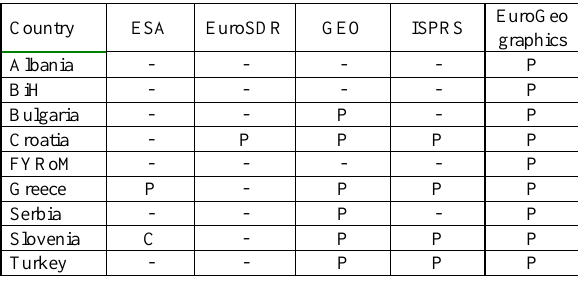
Table 1. Participation in international organizations (P – participating; c – cooperating)